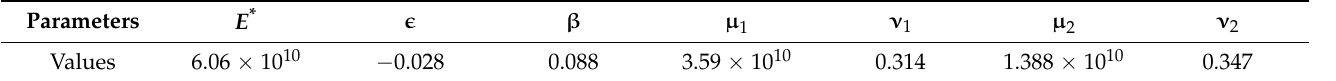
Table 2. Parameters of two-material SAC305–IMC interface.